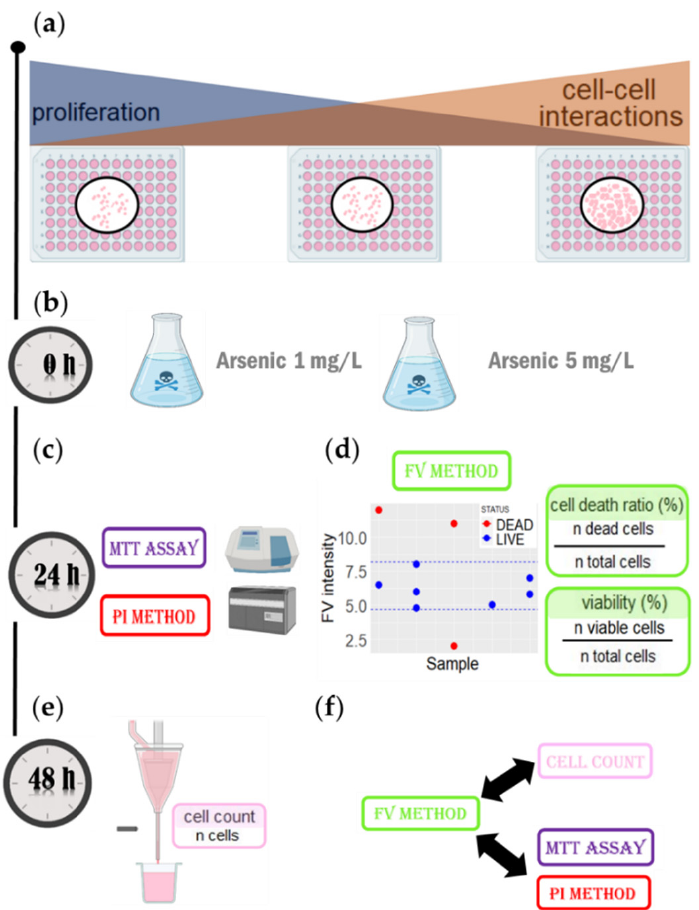
Figure 4. The workflow to evaluate MPCVA accuracy. ( a ) Cells were seeded at different concentrations to achieve different confluency (50%, 75%, and 100%, respectively). ( b ) After the cells were seeded, arsenic (V) (1 mg/L and 5 mg/L) was added to the treated groups. ( c ) At 24 h after treatment, cell viability was determined using MTT assay and PI method. ( d ) At the same time, the MPCVA method was performed. In the side scatter plot, the dashed blue line represents the FV viable intensity range, based on which cell viability and cell death were calculated. ( e ) At 48 h after treatment, cell viability was determined using the cell count method. ( f ) The accuracy of the MPCVA method was compared with the cell count method, as well as with the MTT assay and the PI